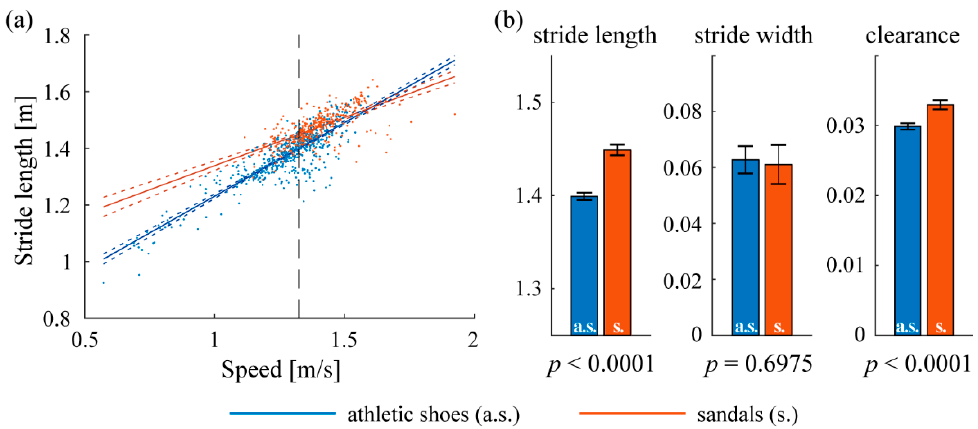
Figure 7. Spatiotemporal gait parameters on path (ii) (Figure 6), the hallway from the subject’s office to the restroom and drinking fountain. Blue and red indicate wearing athletic shoes (a.s.) and sandals (s.), respectively. ( a ) Linear regression of stride length on walking speed. Dotted lines represent 95% confidence intervals and the vertical dashed line represents the mean speed (1.32 m/s) where population marginal means of the two conditions are compared. The slopes of both fitted lines are significantly different from zero ( P < 0.0001), indicating significant dependence on speed. Thus, ANCOVA is used for the comparison to account for the differences caused by different speeds. ( b ) Population marginal means of stride length, stride width and clearance; error bars indicate 95% confidence intervals.